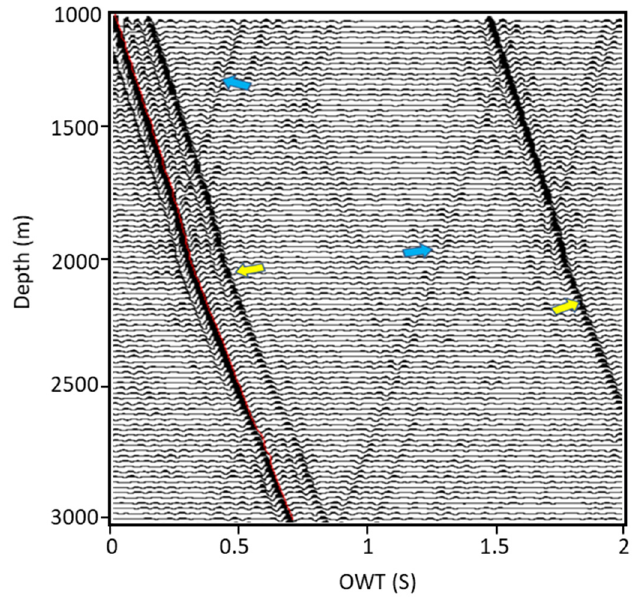
Figure 9. The retrieved VSP data from ANSI. The red line shows downgoing first arrival, the yellow arrows show downgoing multiples, and the blue arrows are pointing at upgoing waves or reflec- tions.